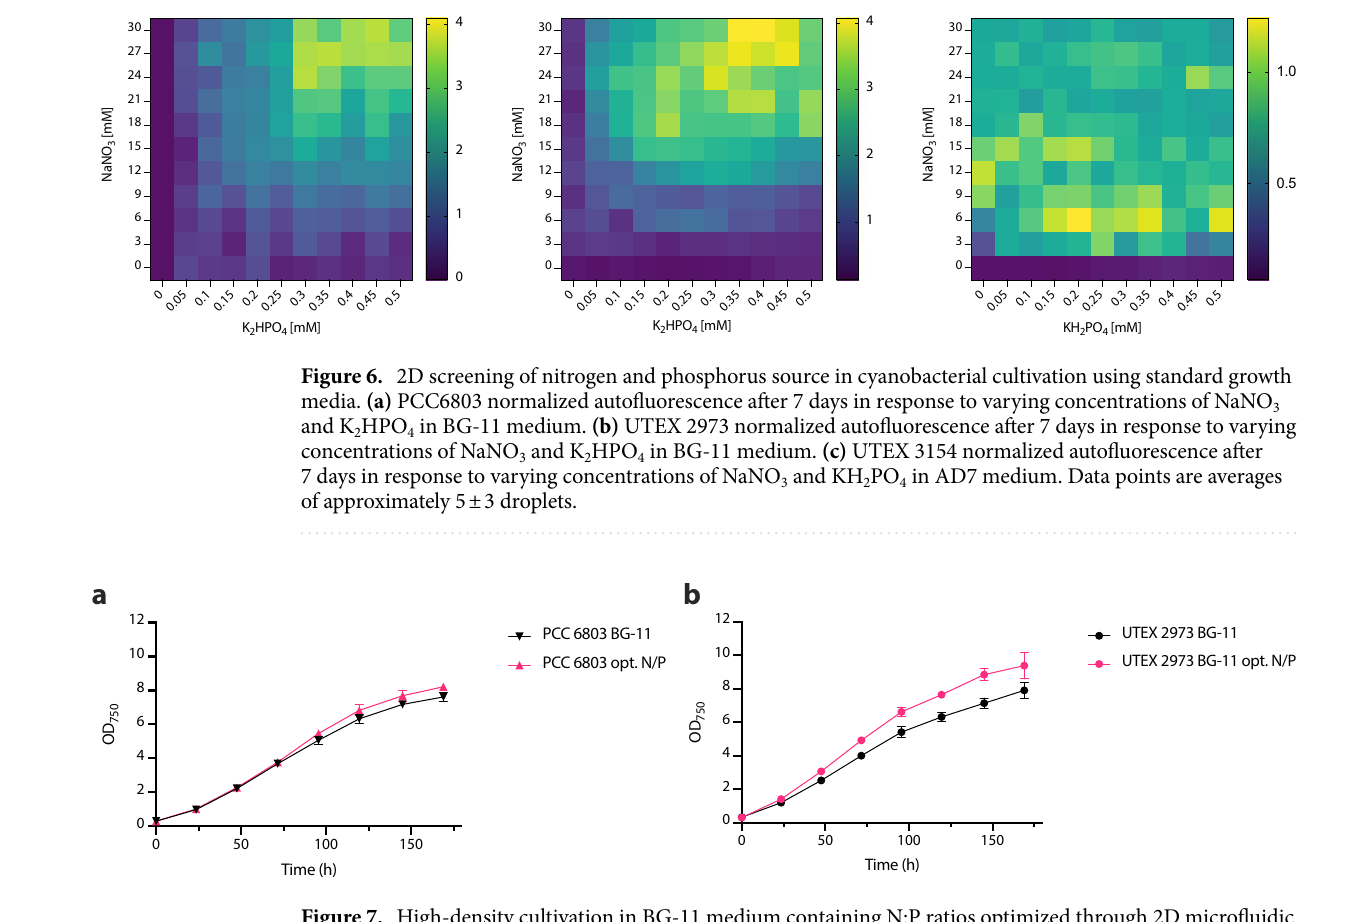
Figure 7. High-density cultivation in BG-11 medium containing N:P ratios optimized through 2D microfluidic screening. Growth of (a) PCC 6803 and (b) UTEX 2973 in standard vs. optimized N/P ratio observed by measuring optical density (OD) at 750 nm. n = 3 and error bars represent standard